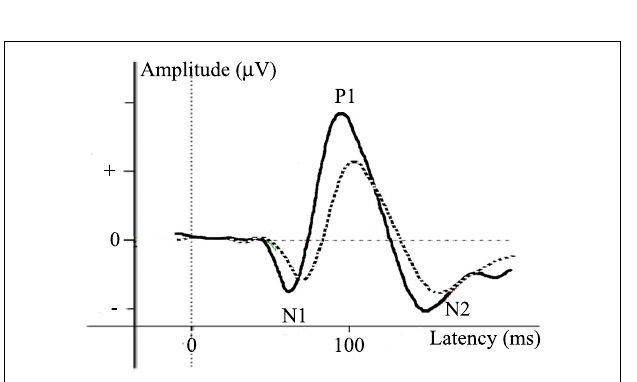
FIGURE 3 | Example of visual evoked potentials (VEPs) with positive and negative peaks of varying latency and